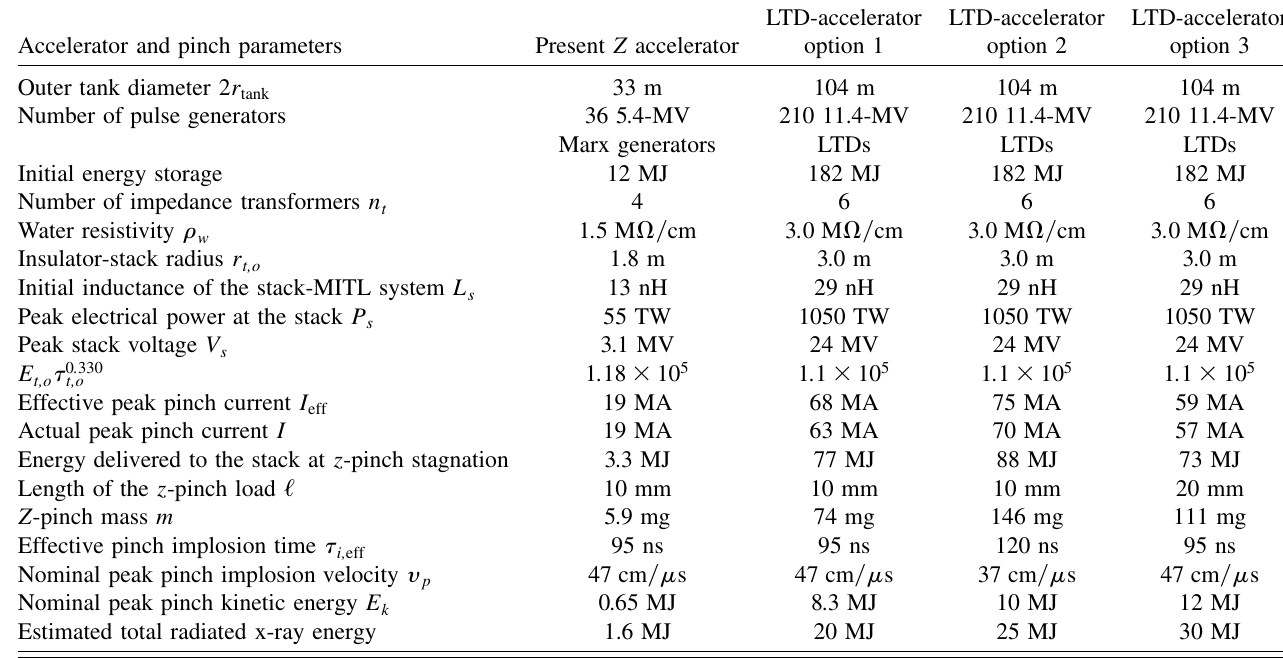
TABLE II. Accelerator and z -pinch parameters for three LTD-based-accelerator options. The parameters are compared to those of the existing Z accelerator [22–31,40,42]. For these options the design of the accelerator itself is identical; the options differ only due to differences in the z -pinch loads. For the Z accelerator and all three higher-current options, the initial pinch radius is assumed to be 10 mm. The nominal values of the peak pinch implosion velocity and kinetic energy assume a 10:1 pinch-radius convergence ratio. The effective peak pinch current and effective implosion time are defined in Appendix